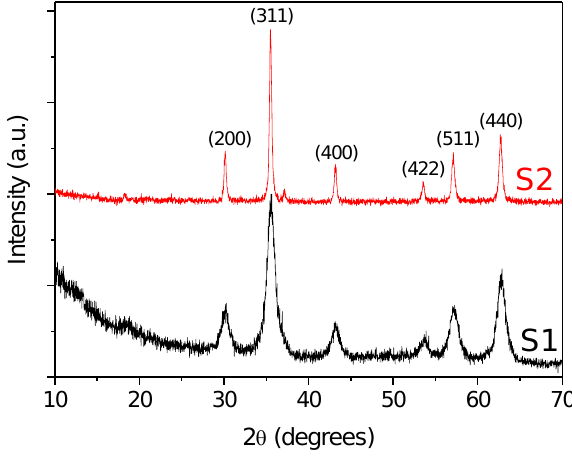
Figure 4. X-ray powder diffractogram (XRD) for the coated F 3 O 4 nanoparticles: S1) 6.3 nm and S2) 10 nm.